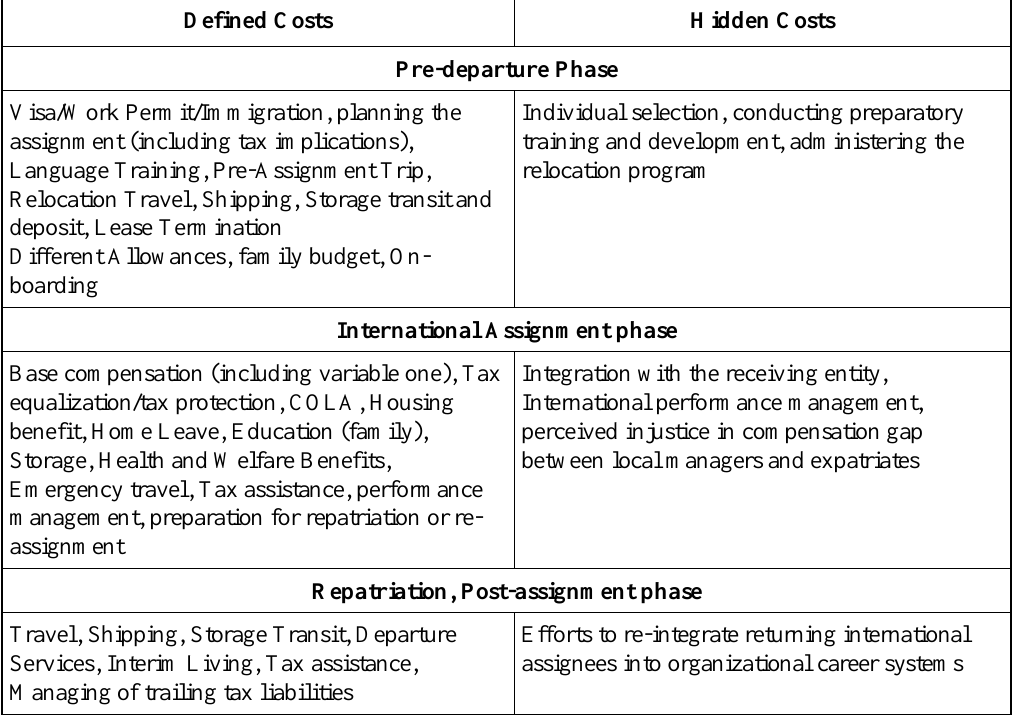
Table 1: Cost Items Driving the Expatriate Invested Capital Defined Costs Hidden